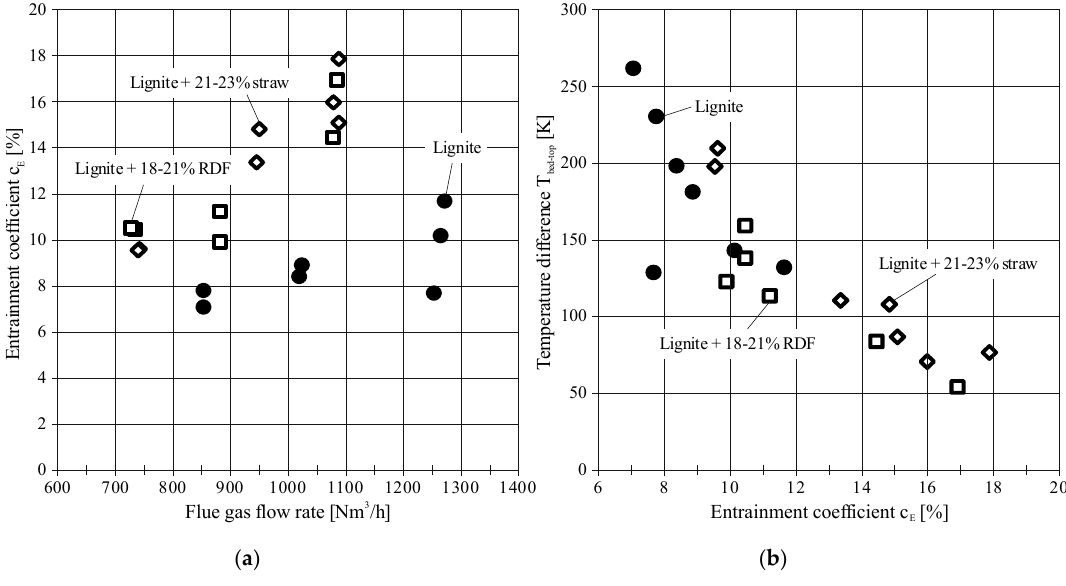
Figure 5. Entrainment coefficient ( a ) and temperature difference ( b ) (similar share of co-fuel).